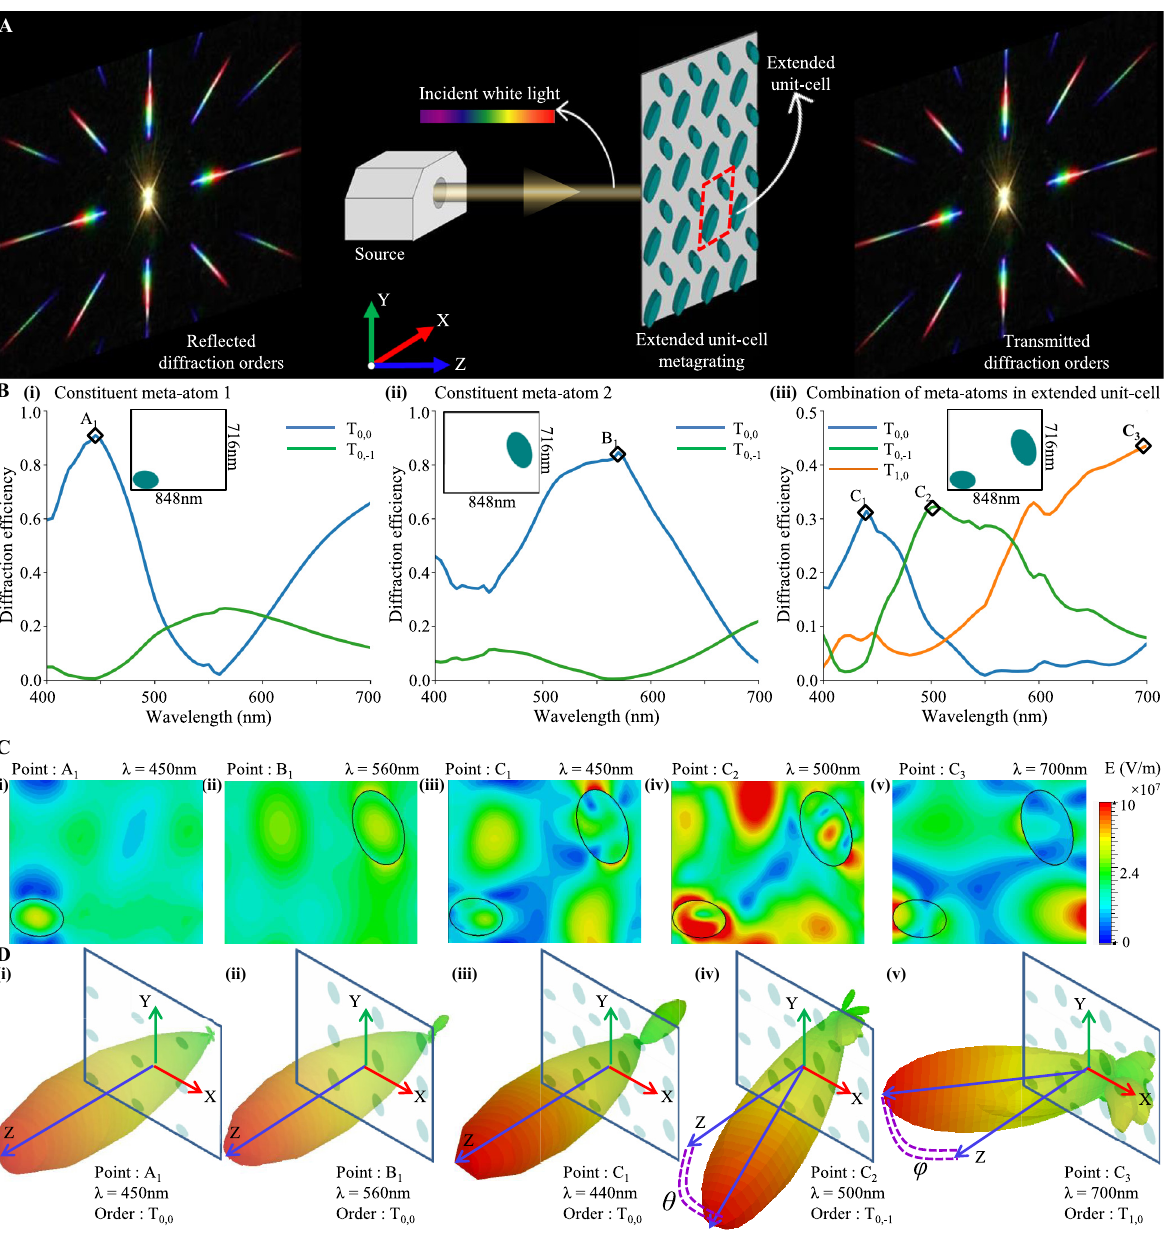
Figure 1: The extended unit cell metagrating and its optical response. (A) Schematic of the extended unit-cell metagrating and scattering patterns of a metagrating dividing lights equally among orders when subjected to white light. Both transmitted and reflected diffraction orders are shown. (B) Comparison of diffraction efficiencies of three metagratings across different diffraction orders. The metagratings are constructed by periodically extending (i) first constituent meta-atom in a unit-cell, (ii) second constituent meta-atom in a unit-cell and (iii) both meta-atoms in an extended unit-cell. Peak diffraction efficiencies are marked. (C) E field distributions and (D) scattering power patterns corresponding to marked points in B are shown. a 13-dimensional parameterized vector. Fixing the x and y position of the center of one of the ellipses to (0,0) allows us to reduce the dimensionality of the solution space by